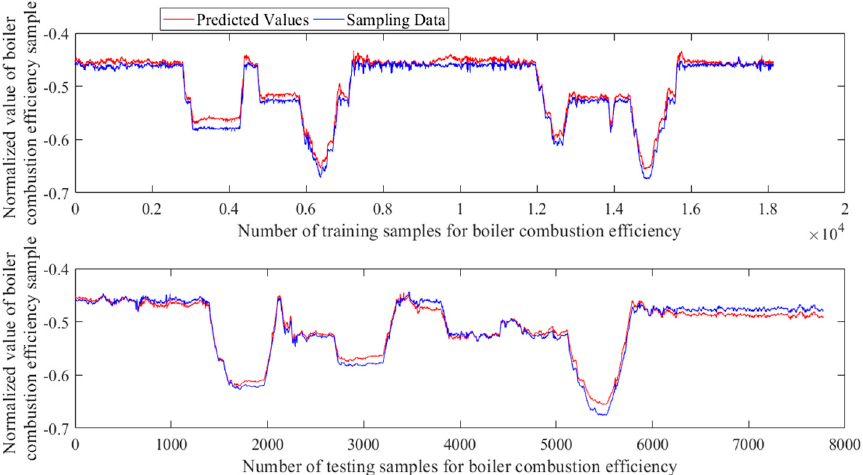
Figure 8. Prediction of boiler combustion efficiency.